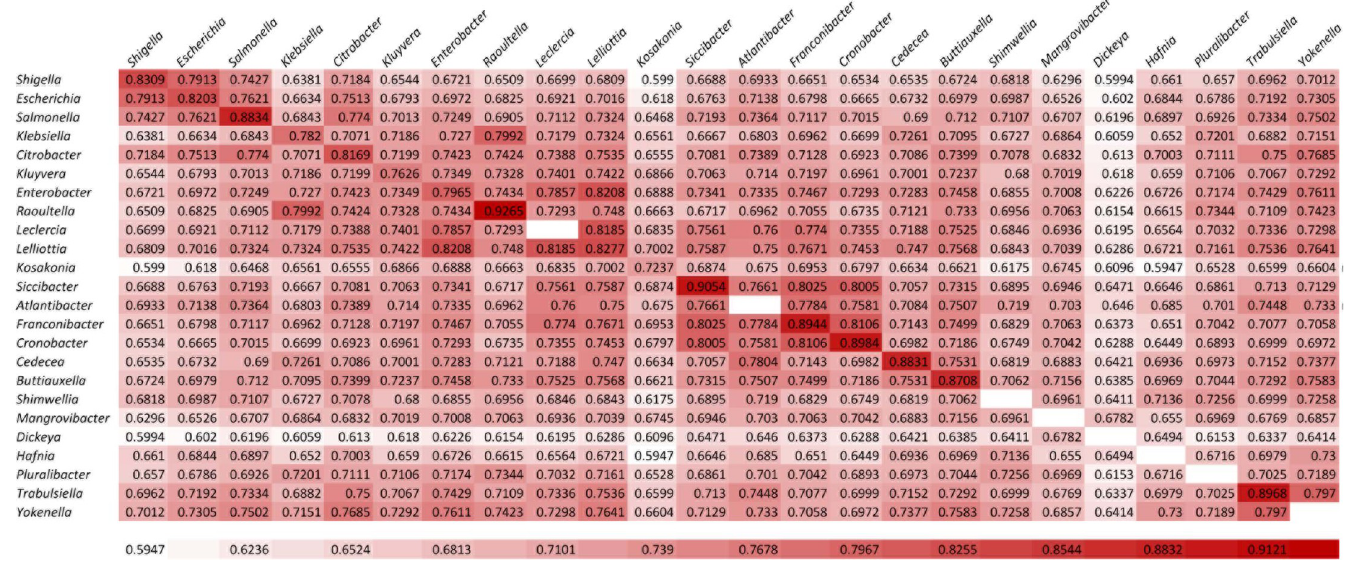
Fig 1. A comparison matrix showing the averages of the percentage of conserved proteins (POCP) within and between different genera of the family Enterobacteriaceae . POCP was determined for all genome sequenced species from the family Enterobacteriaceae detailed in our earlier work [26]. The values along the diagonal shows the average POCP values for different species within a given genus (i.e. interspecies values), whereas all other values represent average intergeneric POCP values for different genera within this family. The blank cells indicate that only a single species was available for these genera and hence their interspecies values could not be calculated.